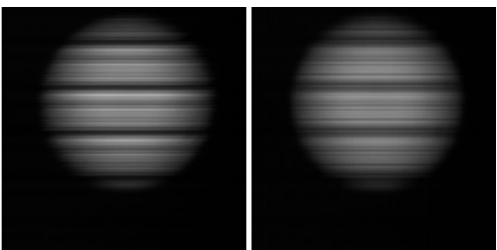
Figure 10. The VLP-LED stripe images with motion blur in diagonal direction and vertical direction to the stripes and with a motion blur length of 40 in pixels. Table 2. The vehicle speed of the motion blur images using the vehicle speed detection